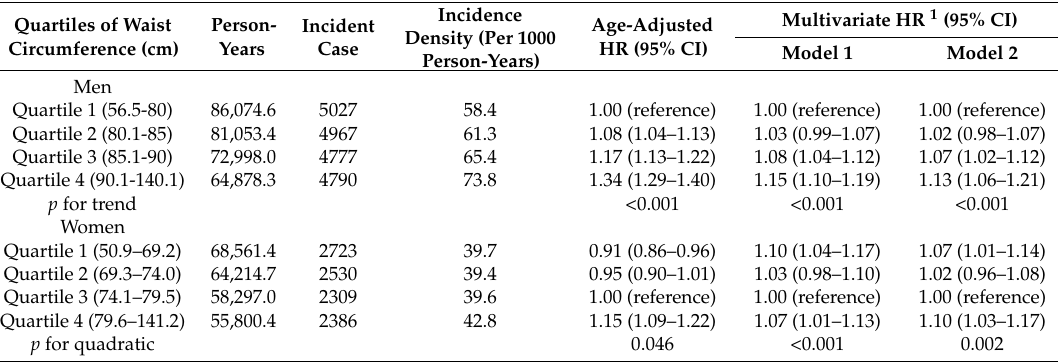
p < 0.001 for the overall interaction between sex and quartiles of waist circumference for reflux